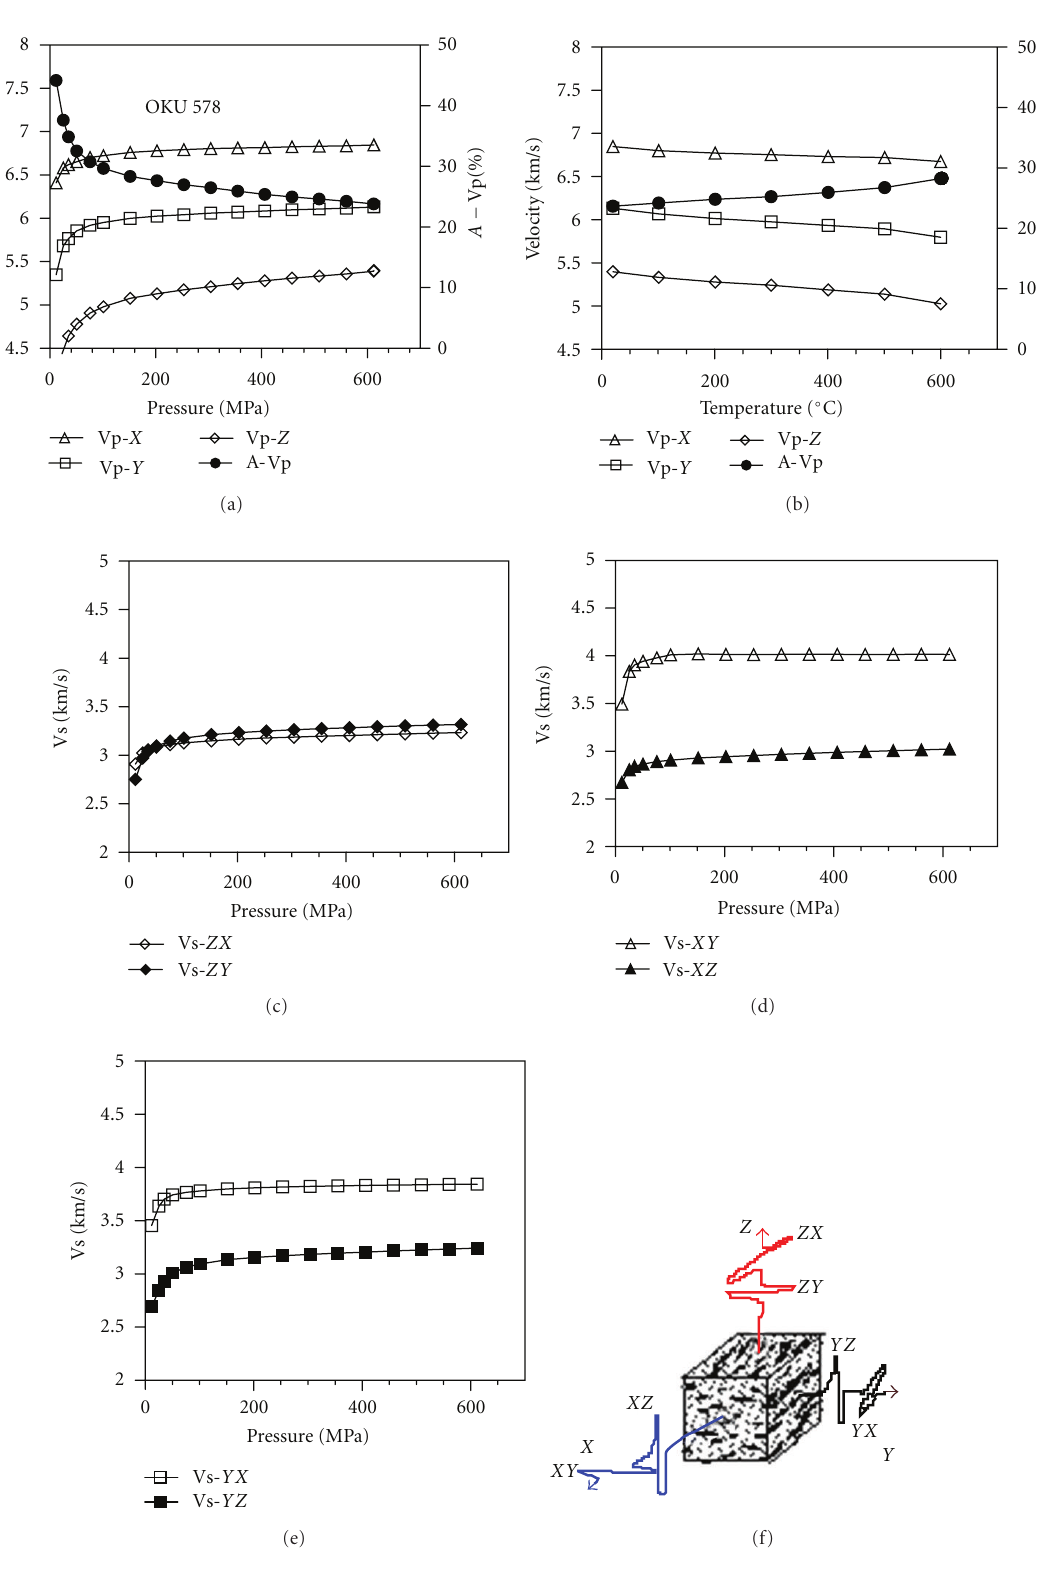
Figure 2: P- and S-wave velocities as a function of pressure up to 600MPa (room temperature) (Figure (a), (c)–(e), resp.) of a biotite gneiss (OKU 578) from Outokumpu, along with the temperature dependence of P-wave velocities measured at 600MPa confining pressure (b). (f) illustrates the measuring directions of P- and S-wave velocities and shear wave polarization according the foliation-related structural frame X , Y , and Z ( XY is foliation, X is lineation, and Z is foliation